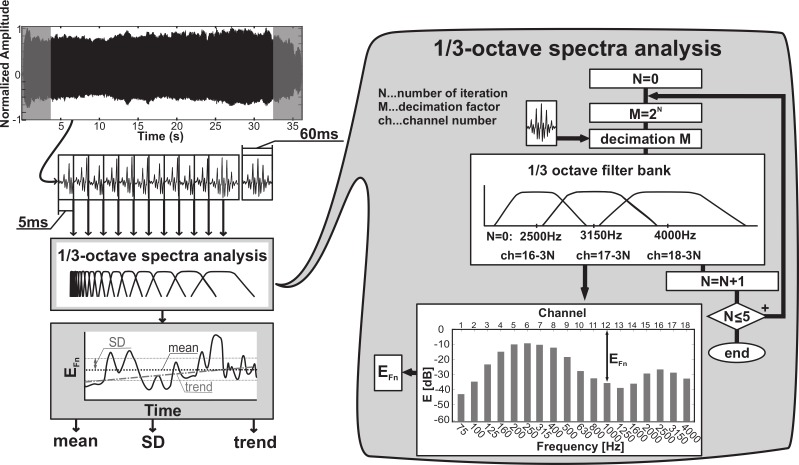
Principle of acoustic analysis based on the 1/3-octave spectra assessment presented in Couvreour (1998).